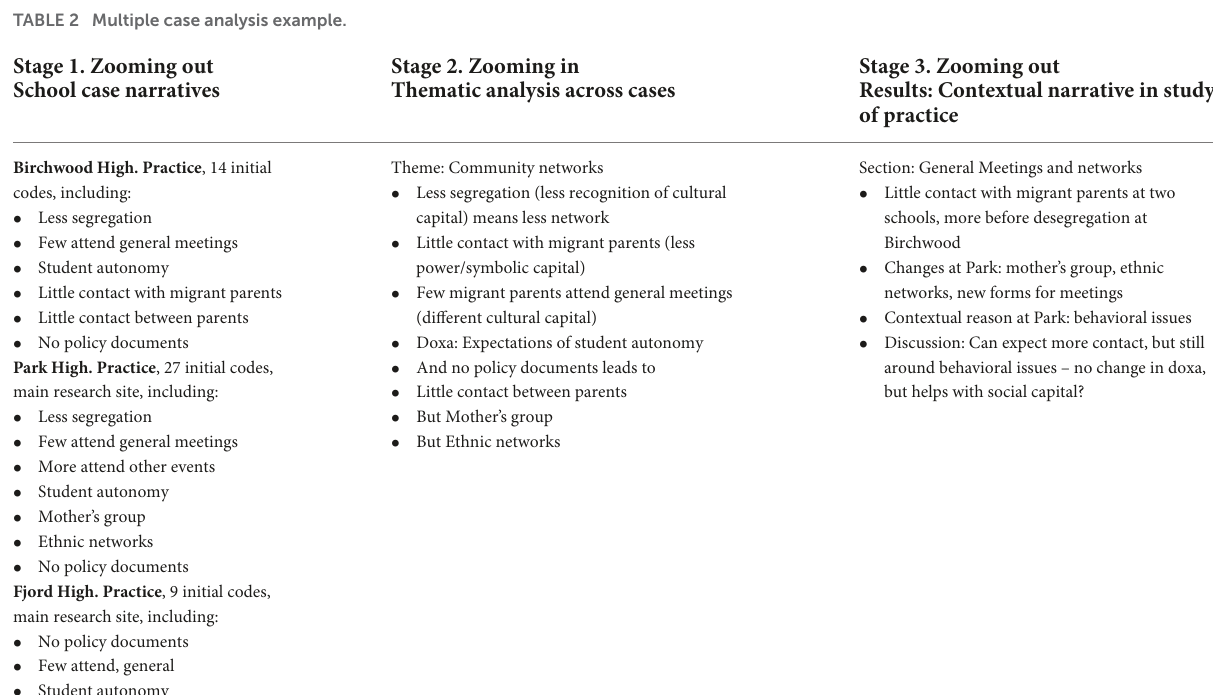
TABLE 2 Multiple case analysis example. Stage 1. Zooming out School case narratives